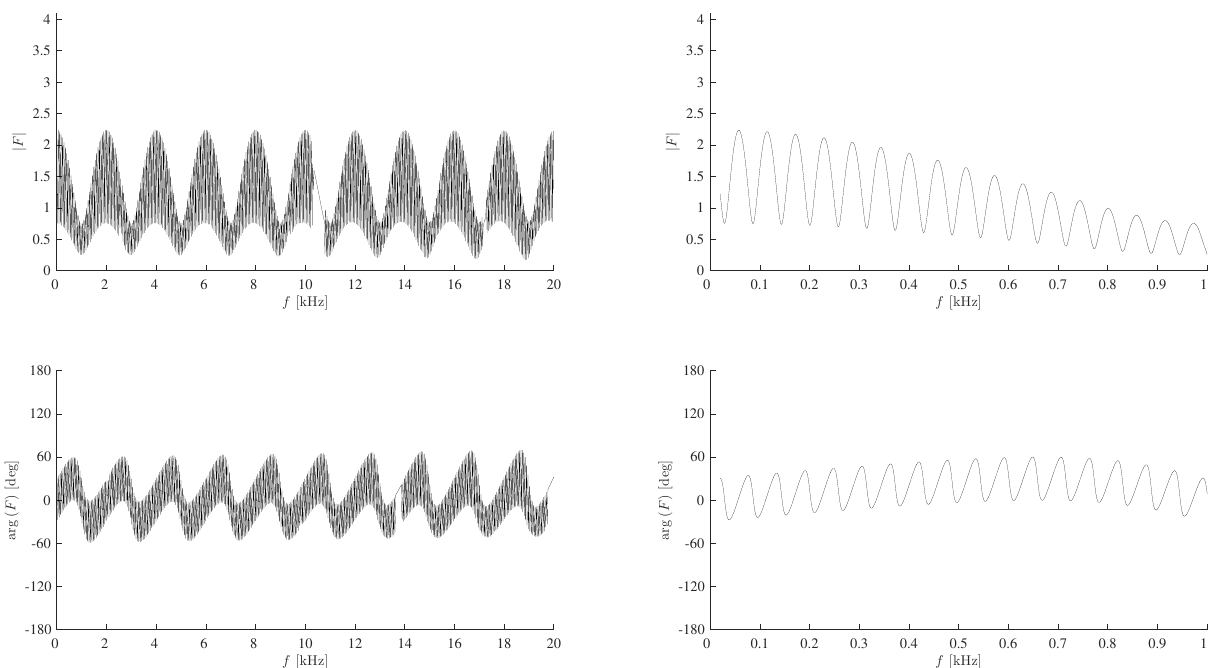
Figure 7: The same as Figure 3, but for halved reflection factor on the the ground and on the wall, R h = R v = 0.5 .